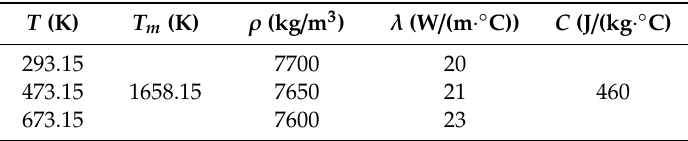
Table 5. Thermal properties of AISI D2 tool